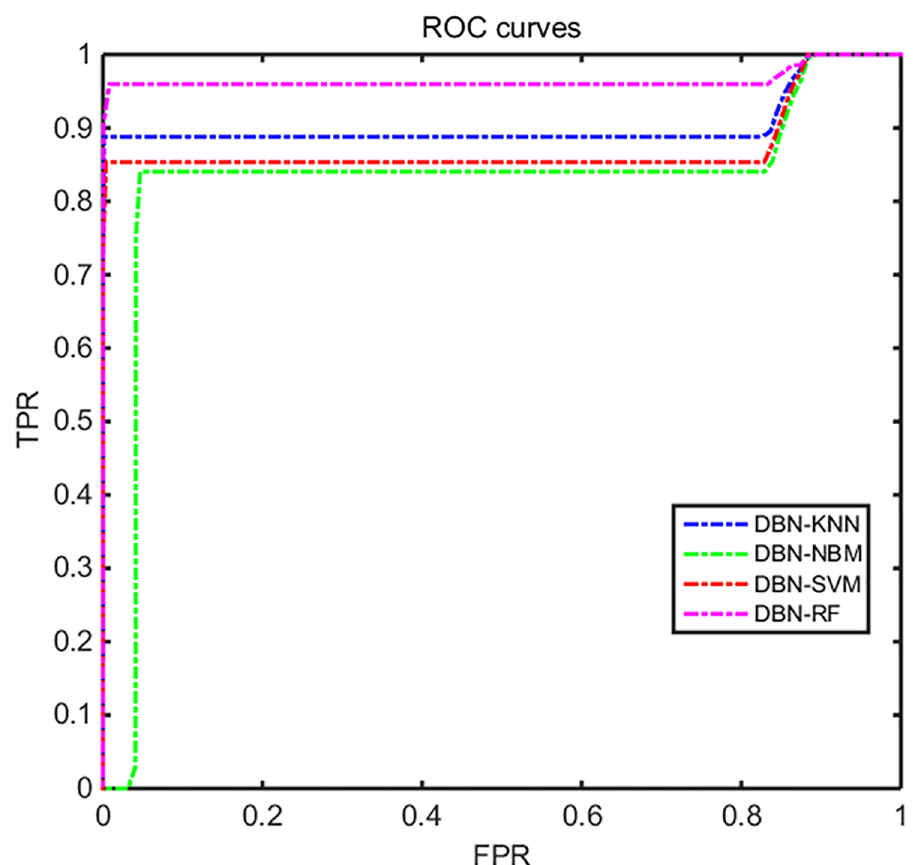
Fig 15. The ROC curve of different algorithm. We selectedthe classification results of a representative class, drew its ROC curve, and comparethe classification performance of the different algorithms, which is shown in Fig 15. From Fig 15, we can obviouslysee that the classificationperformance of DBN-RF is better than that of the other algorithms that were used in this article. These results show that the method proposedin this article is effective for processingmulti-classhigh-dimensional spacecraft